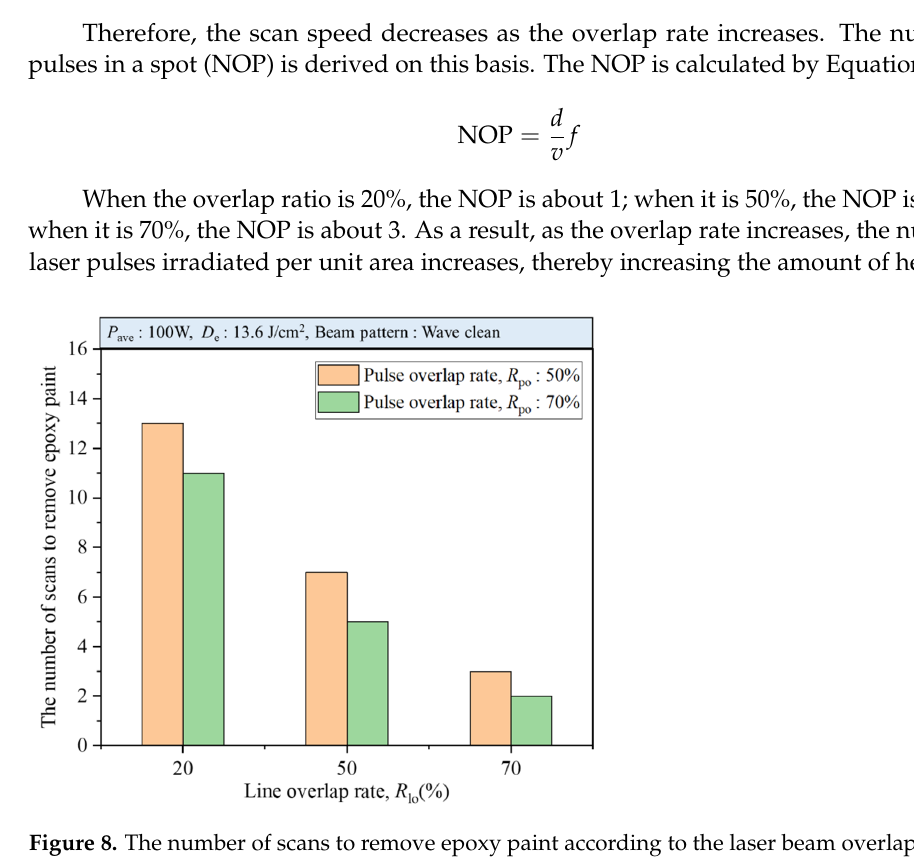
short pulse duration times of ps and fs and high peak powers of GW and MW are required